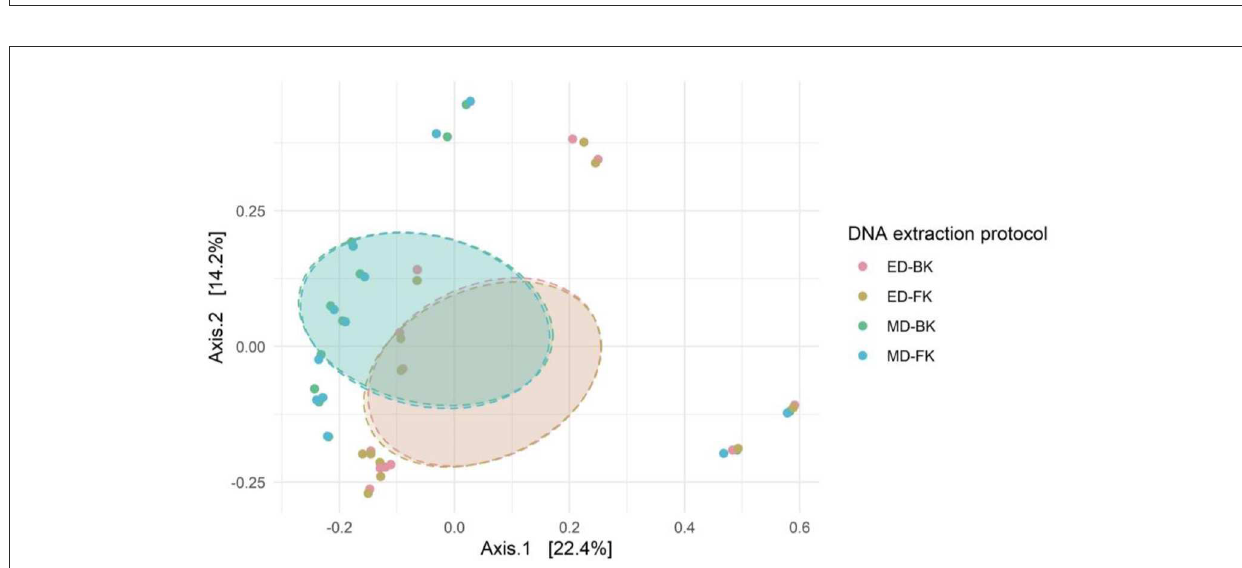
FIGURE7 Bray–Curtis distance in a PCoA ordination shows the difference in overall microbial community structure of the different groups (Bead-beating using the Blood and Fecal kits, i.e., MD-BK and MD-FK, and similarly for lysis buffer, i.e., ED-BK and ED-FK). PERMANOVA testing for the method for